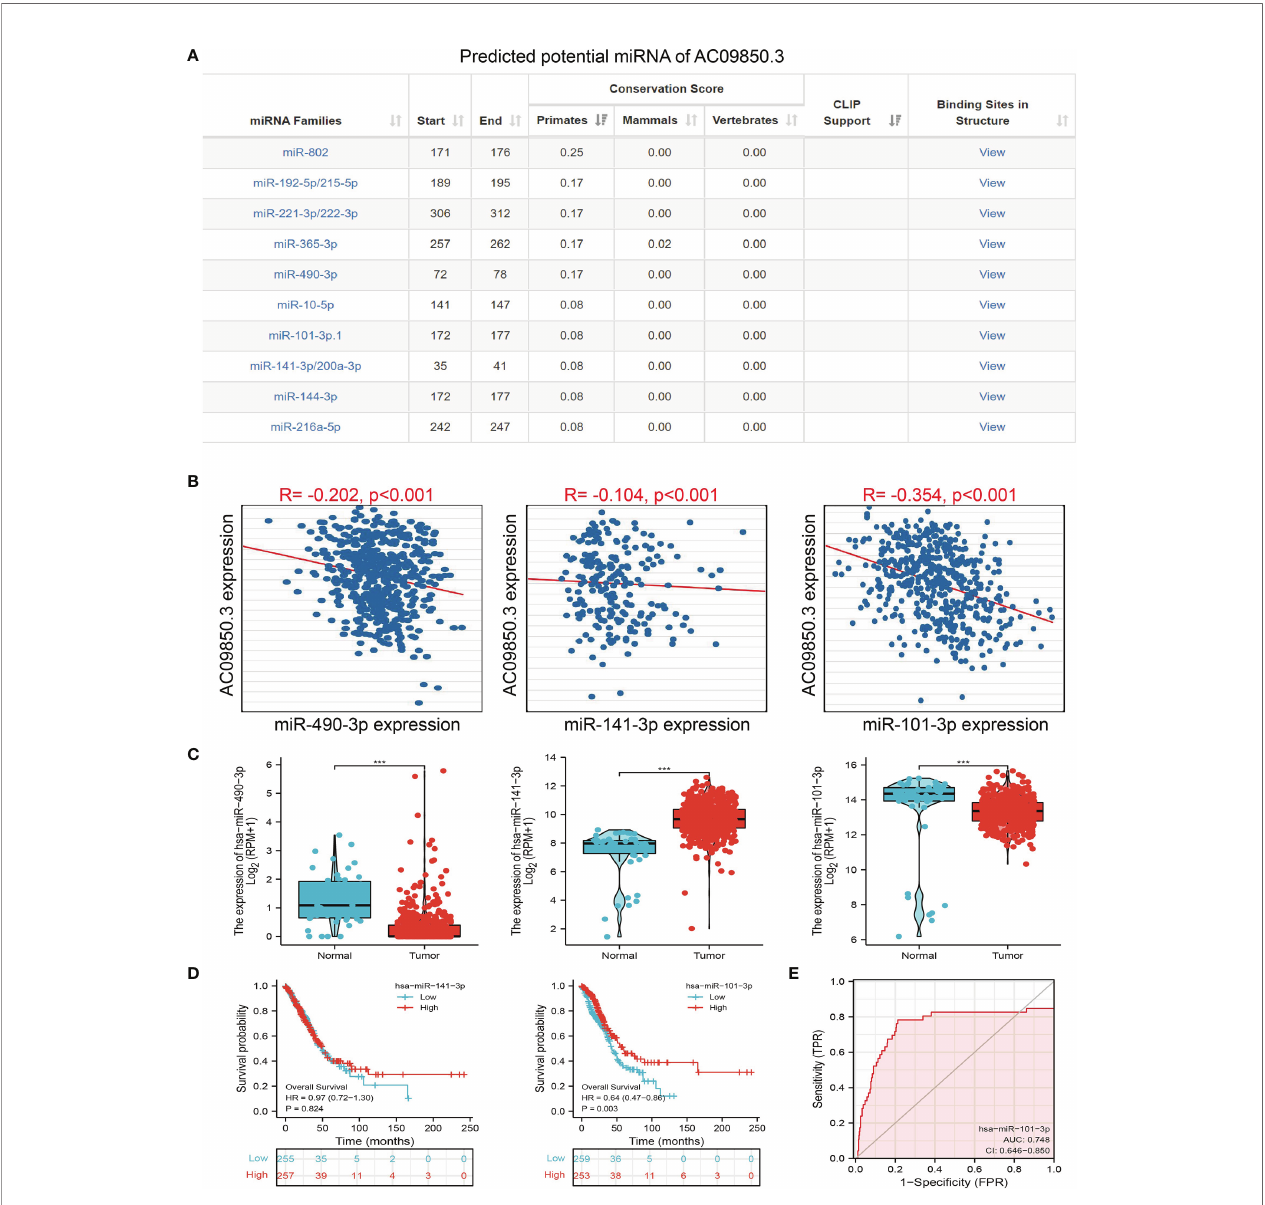
FIGURE 8 | Analysis of the potential miRNAs of AC099850.3. (A) The potential miRNAs of AC099850.3 determined by Anbolnc2 database. (B) Correlations between AC099850.3 expression and miR-490-3p, miR-141-3p, and miR-101-3p in LUAD (C) The expression level of miR-490-3p, miR-141-3p, and miR-101-3p in LUAD (D) The OS of miR-141-3p, and miR-101-3p in LUAD. (E) ROC curve of miR-101-3p in LUAD.